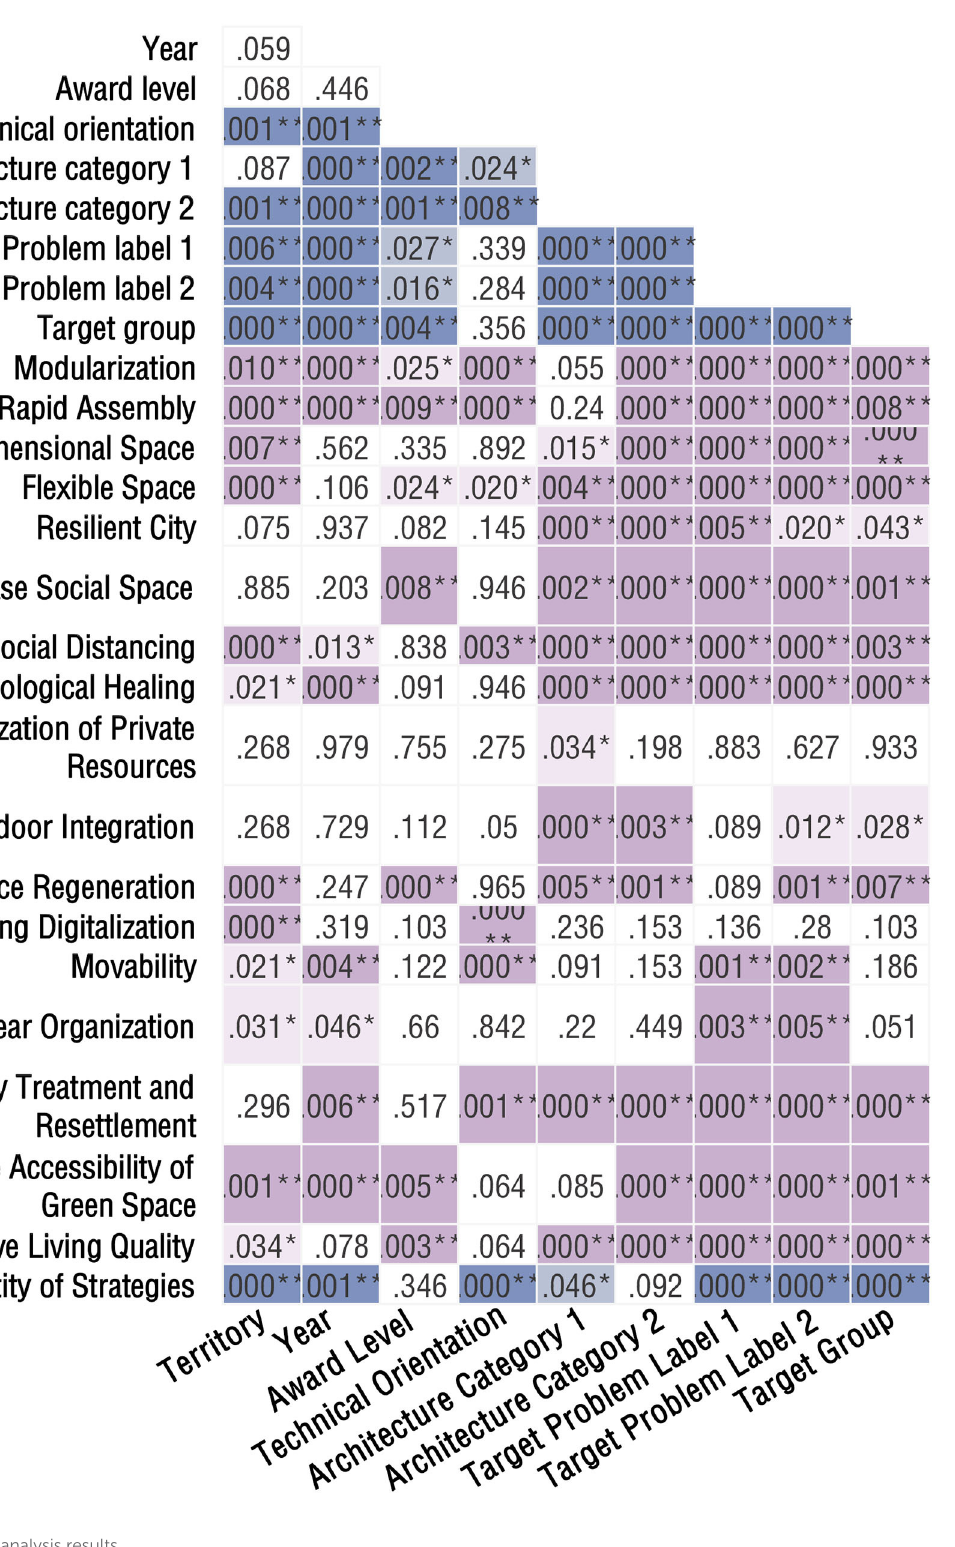
FIGURE7 Pairwise cross-tabulation analysis